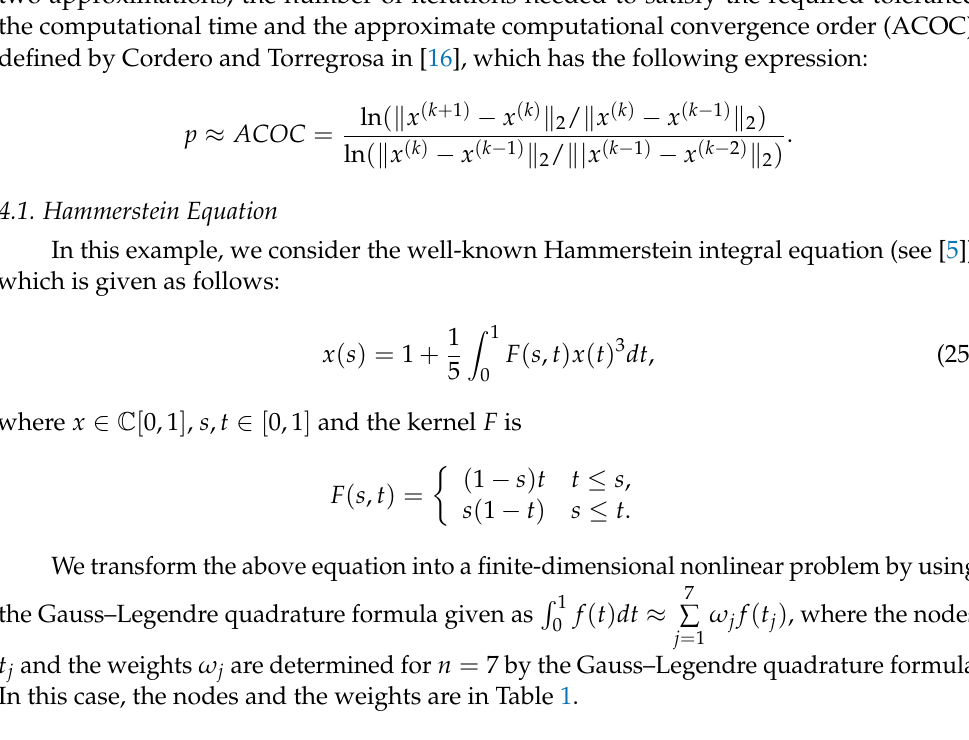
Table 1. Weights and nodes of the Gauss–Legendre